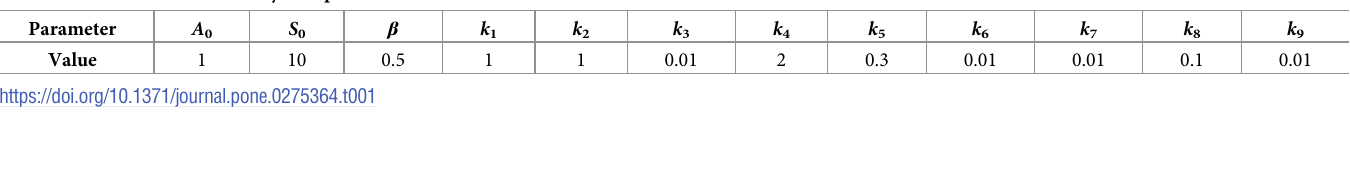
Table 1. Values selected for the system